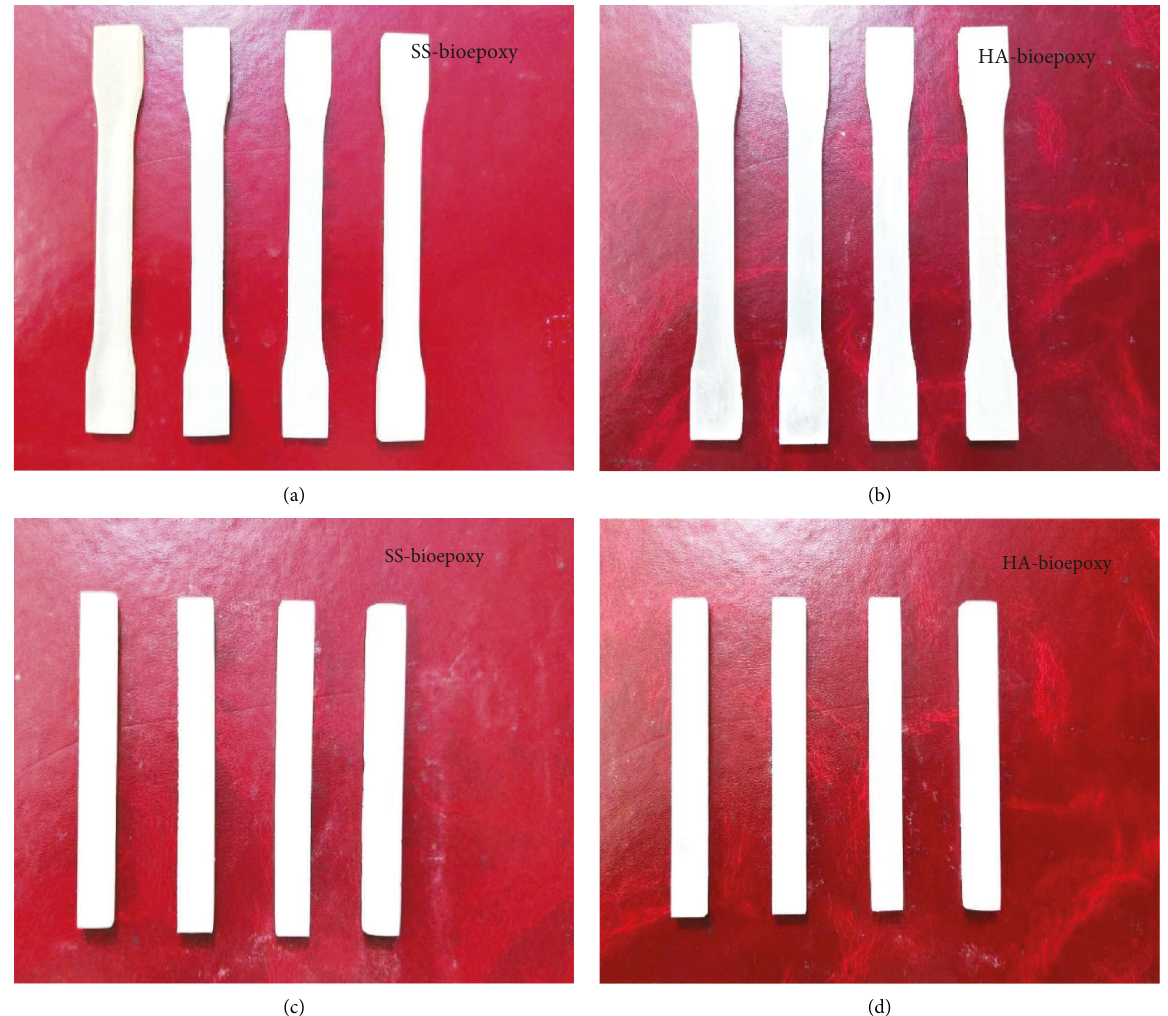
Figure 1: Specimens of SS- and HA-bioepoxy nanocomposites prepared for (a) and (b) tensile test (c) and (d) impact